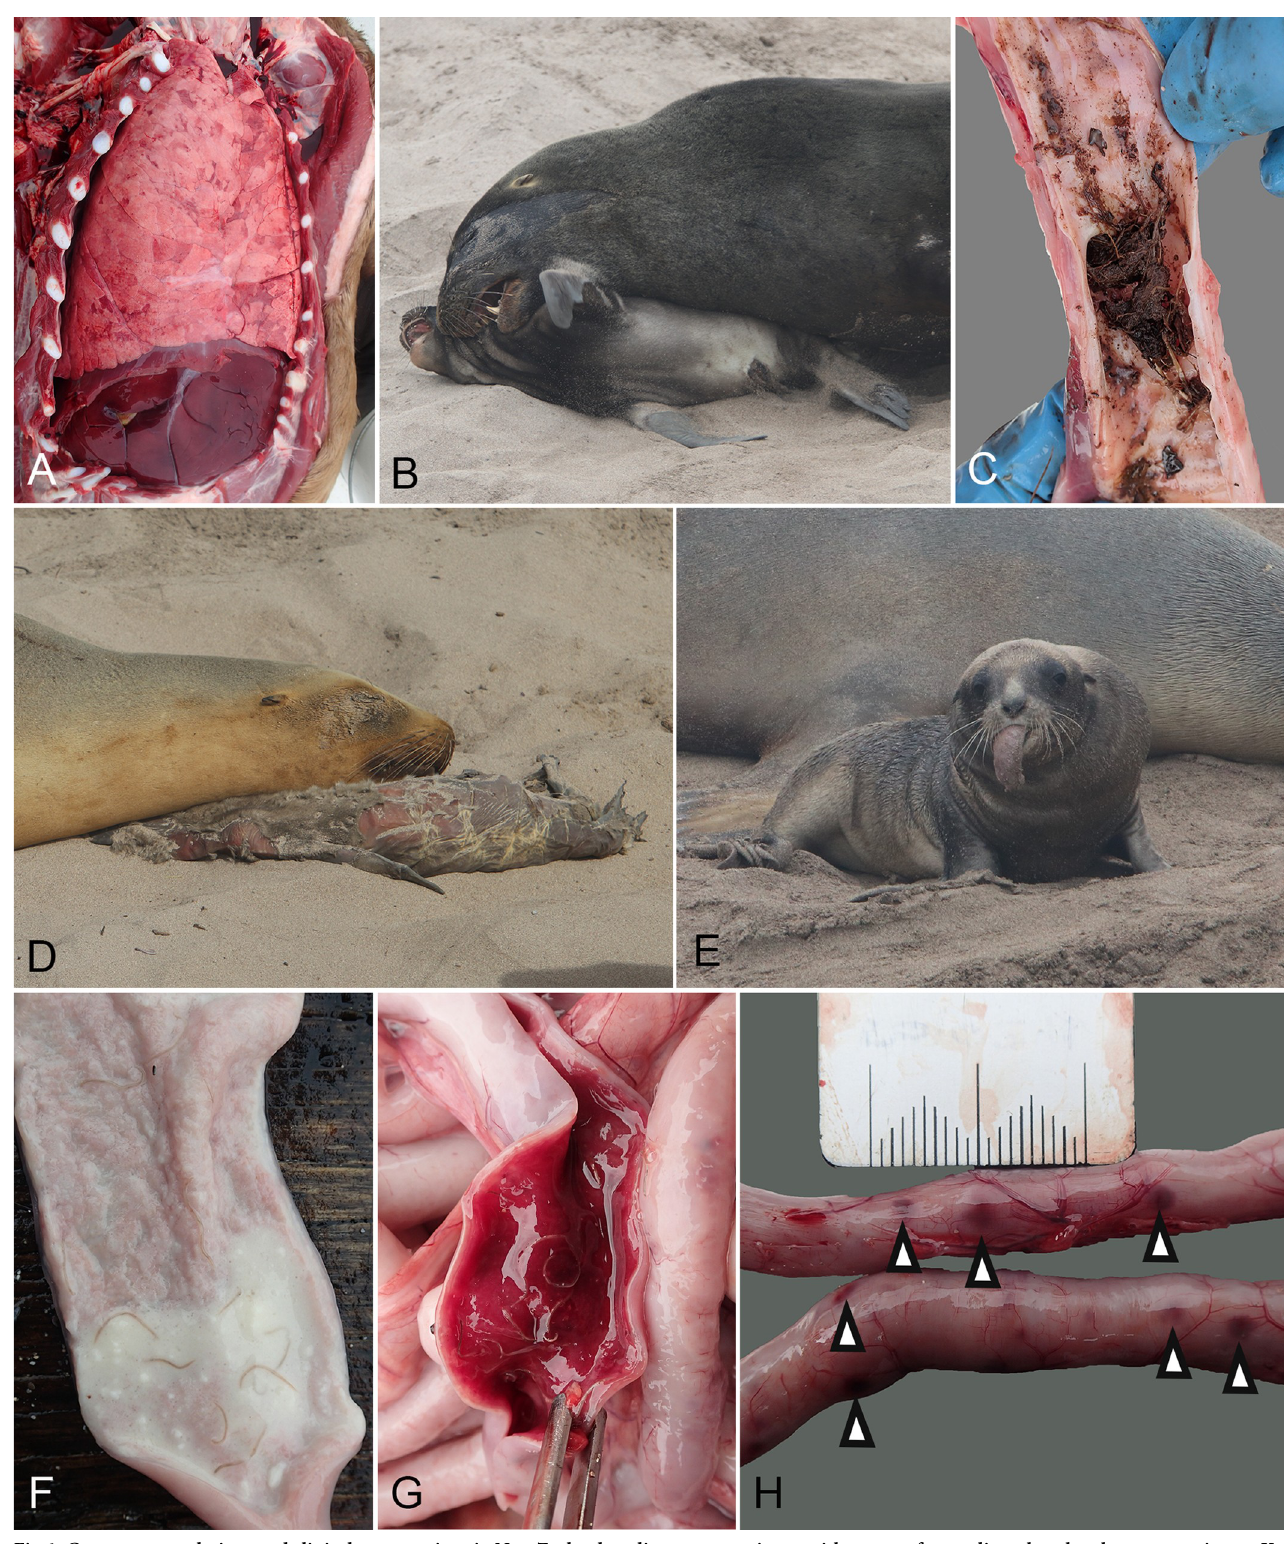
Fig 6. Gross necropsy lesions and clinical presentations in New Zealand sea lion pups consistent with causes of mortality other than hypermucoviscous K . pneumoniae infection. (A) Hyperinflation of the lungs in a case of drowning, note the lung lobes overlapping and obscuring the heart. (B) A subadult male